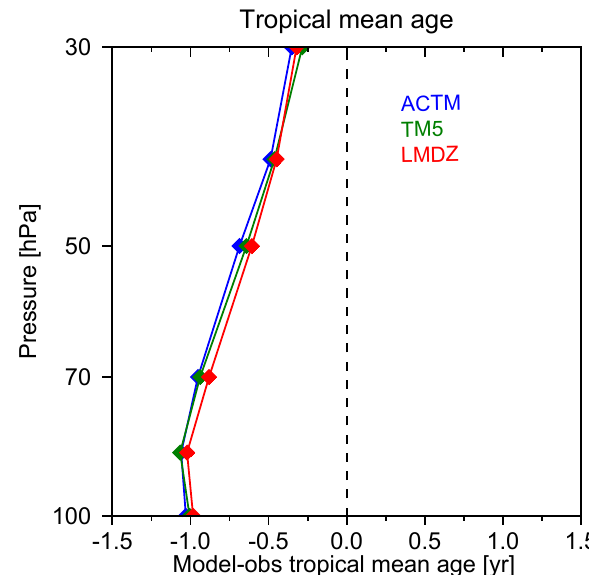
Figure 7. Model–MIPAS differences of mean age for the tropical lower. Mean age data in years (yr) are calculated as annual means on the MIPAS pressure–latitude